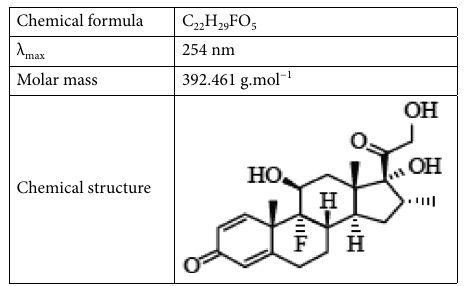
Table1. The characteristics of dexamethasone. UV/MgO processes.